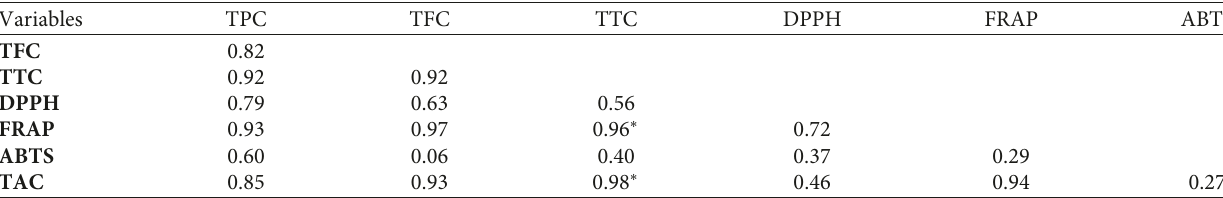
Table 2: Pearson’s correlation coefficients for relationship between antioxidant determination assays.